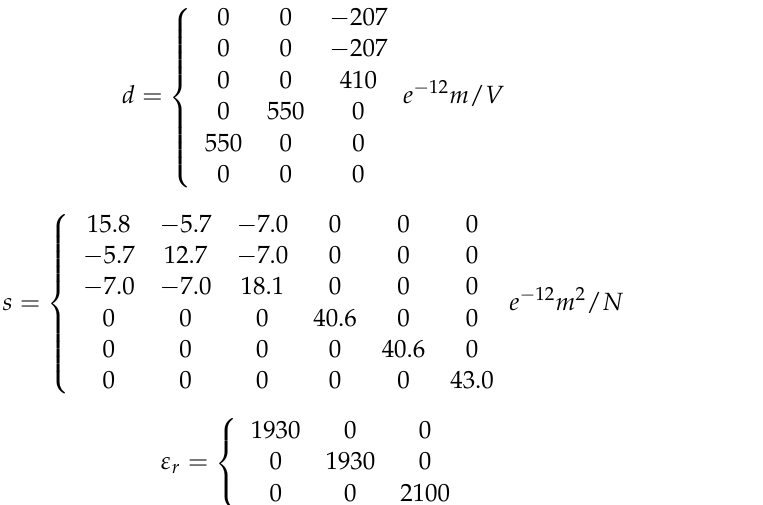
Table 1. Material properties of different structures.